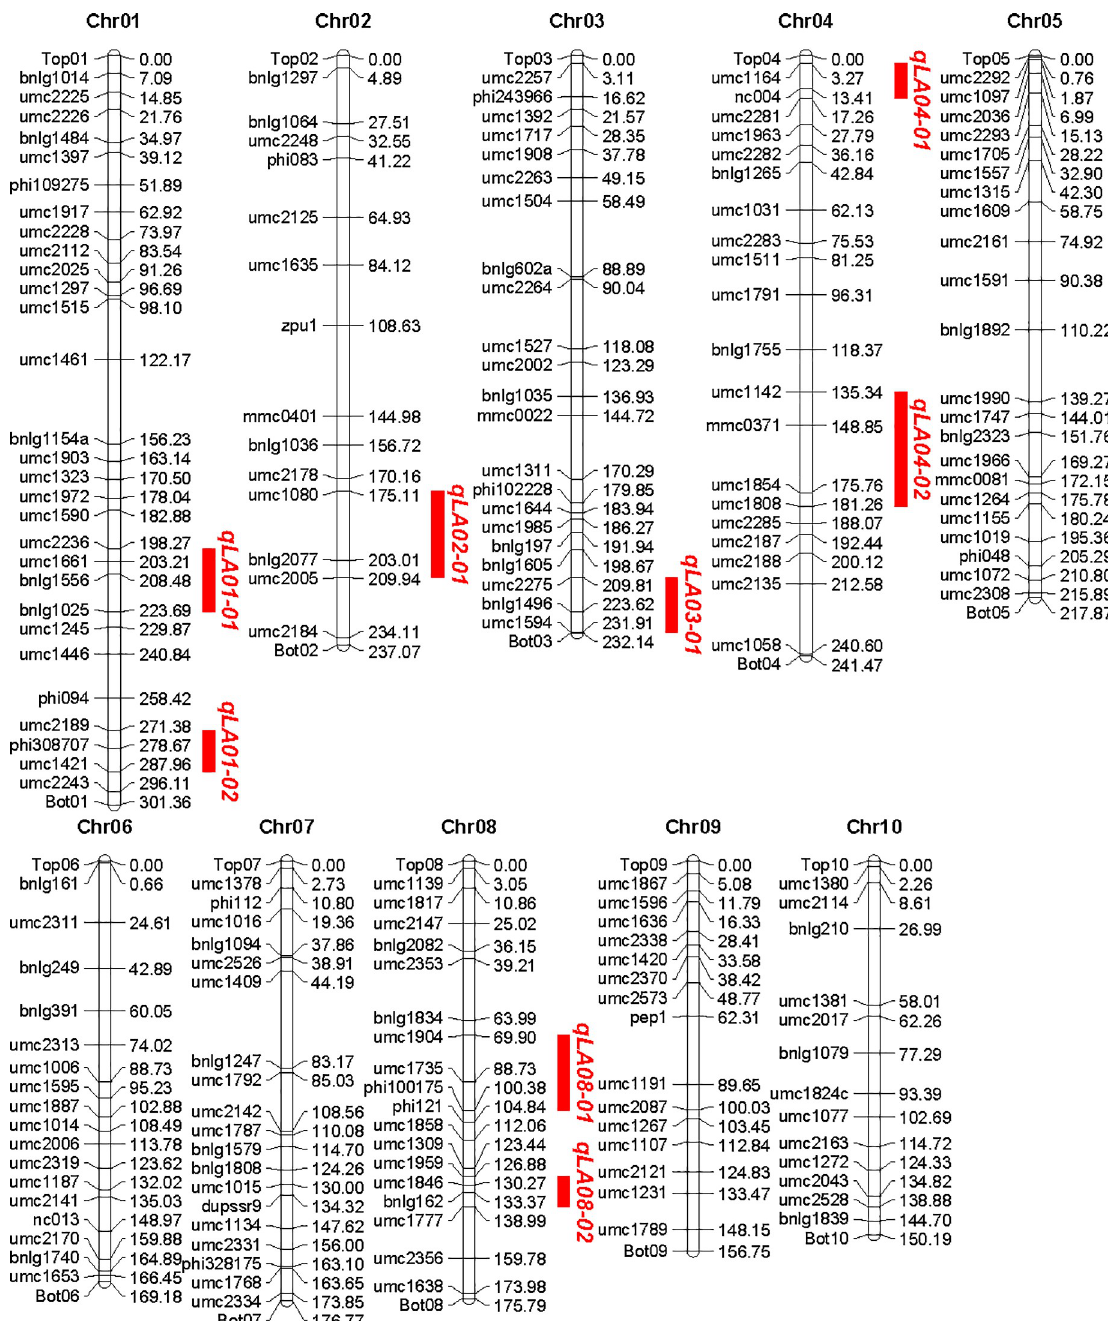
Fig 2. Construction of genetic linkage maps and mapping of QTL for controlling leaf angle in Maize. https://doi.org/10.1371/journal.pone.0245129.g002 QTL analysis of leaf angle was conducted using Map QTL 6.0 software. Eight QTL for leaf angle on chromosome 1, 1, 2, 3, 4, 4, 8 and 8 were detected (Fig 2), respectively, which explained 65.4% of the total phenotypic variance, and each QTL explained phenotypic variance ranging from 4.3 to 14.2% (Table 2). It was noteworthy that all QTL had positive additive effects, sug- gesting that the B73 parent contributed most alleles for increasing leaf angle (Table 2).